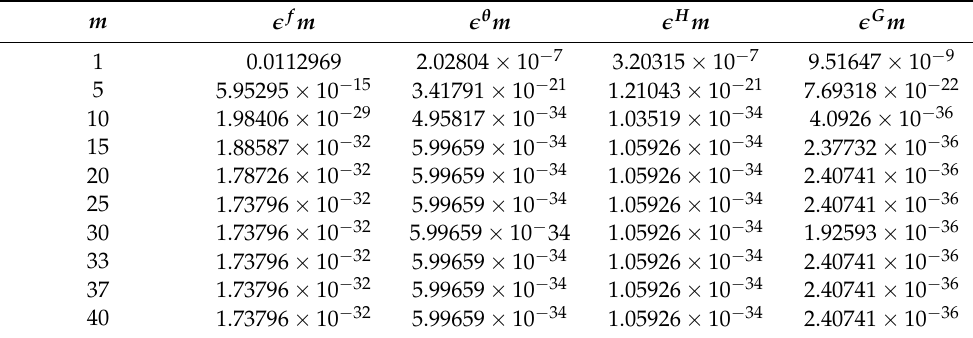
Table 1. Total residual error of f ( η ) , θ ( η ) , G ( η ) and H ( η ) with fixed values of Pr = 0.5, S = −